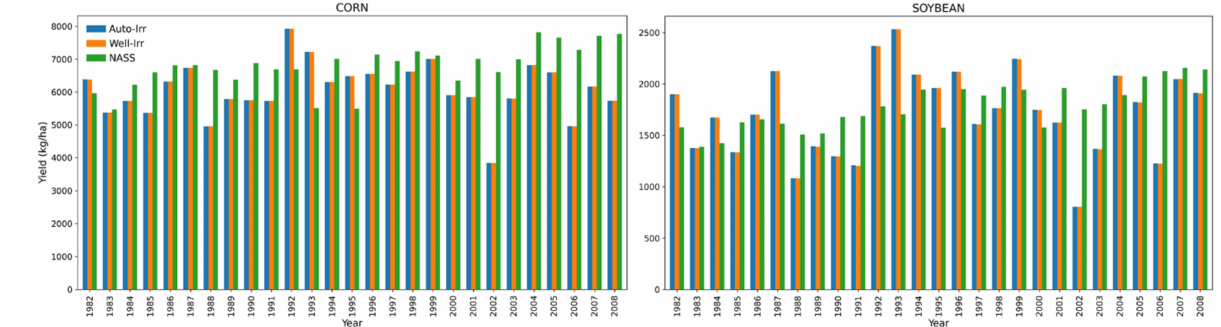
Figure 7. Comparison between Auto-Irr simulated and NASS corn and soybean yield in the